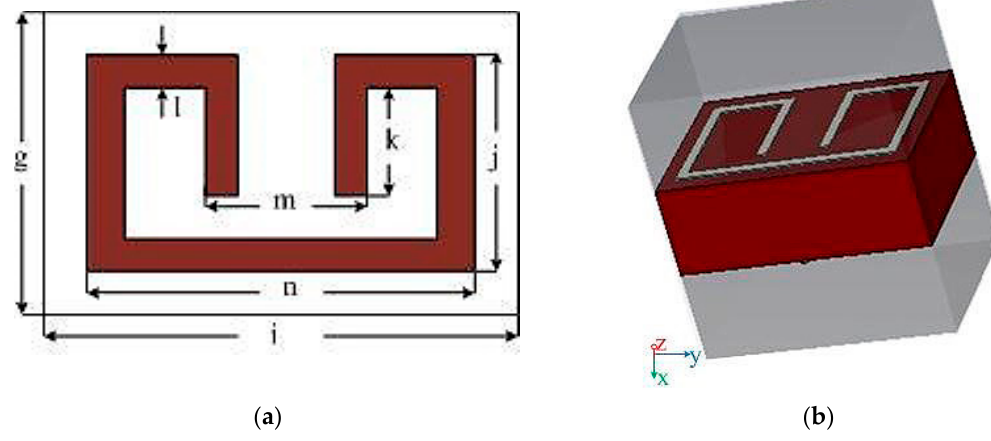
Figure 5. Metamaterial unit cell; 2D view ( a ), 3D view ( b ). Table 1. Optimized antenna parameters.